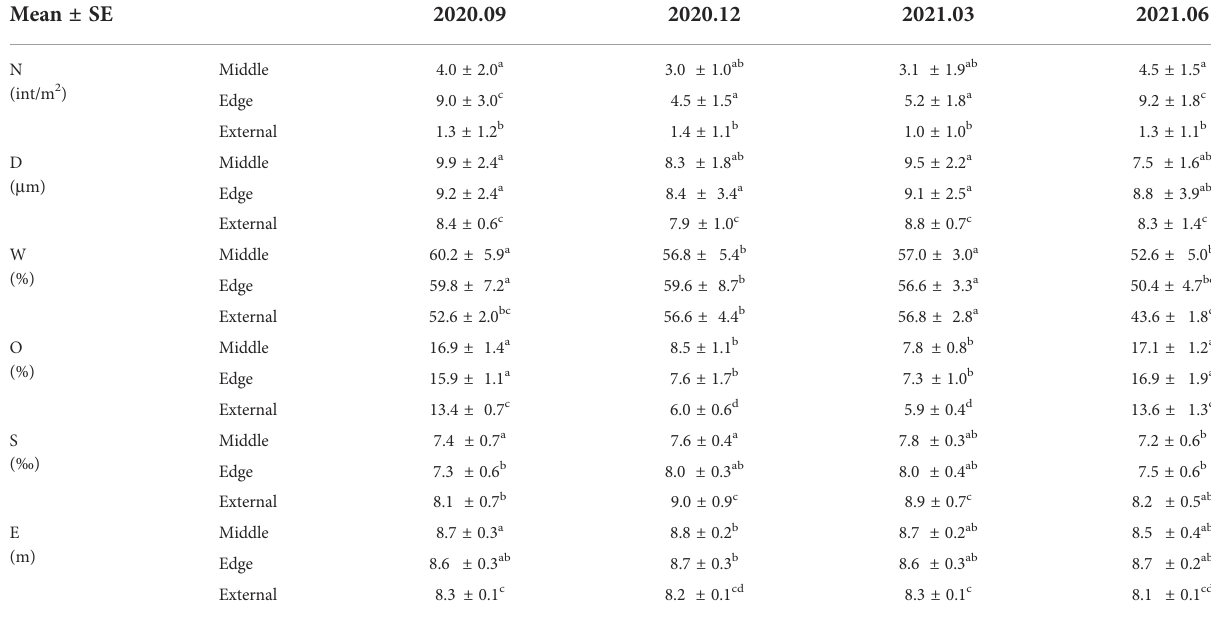
Different superscript letters indicate signi fi cant differences between different cases